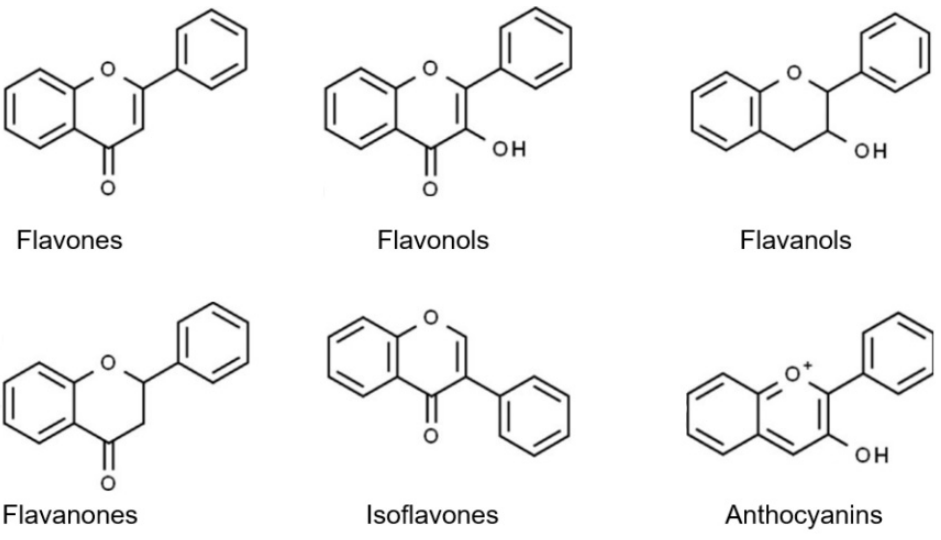
Figure 1. Basic structures of the major naturally occurring flavonoids.